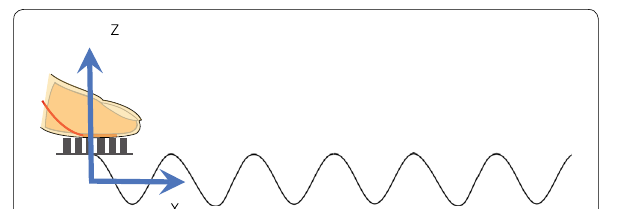
Fig. 3 Undulation surface coordinates. The flat surface and the undulation peak are at the same level